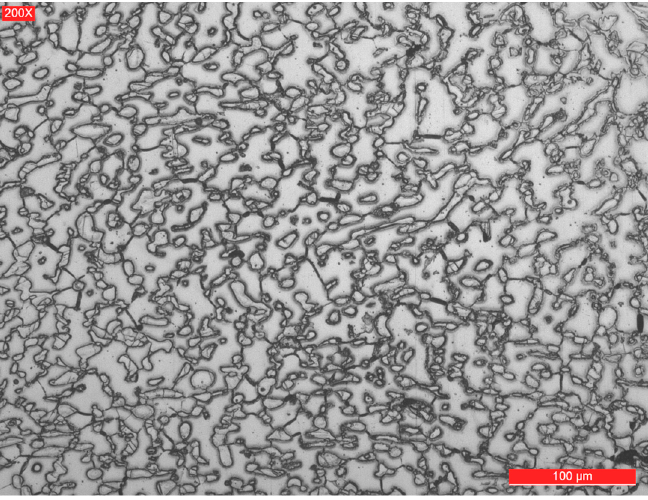
Figure 5. Microstructure of the base metal.